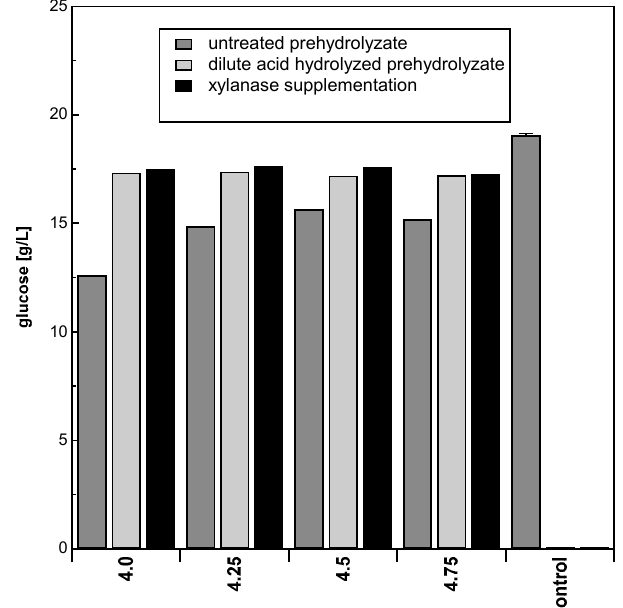
Figure 10. Initial glucose concentrations (24 h) in the enzymatic hydrolysis of Avicel in the presence of 210 °C steam explosion prehydrolyzates: effect of xylanase supplementation and acid hydrolysis of xylooligomers. The dark grey bar on the right site of the graph denotes the glucose concentration in the control without prehydrolyzate. One group of prehydrolyzates was subjected to a dilute acid hydrolysis to convert xylooligomers to xylose (light grey bars). Alternatively, xylanase was added to the enzymatic hydrolysis mixtures (black bars).